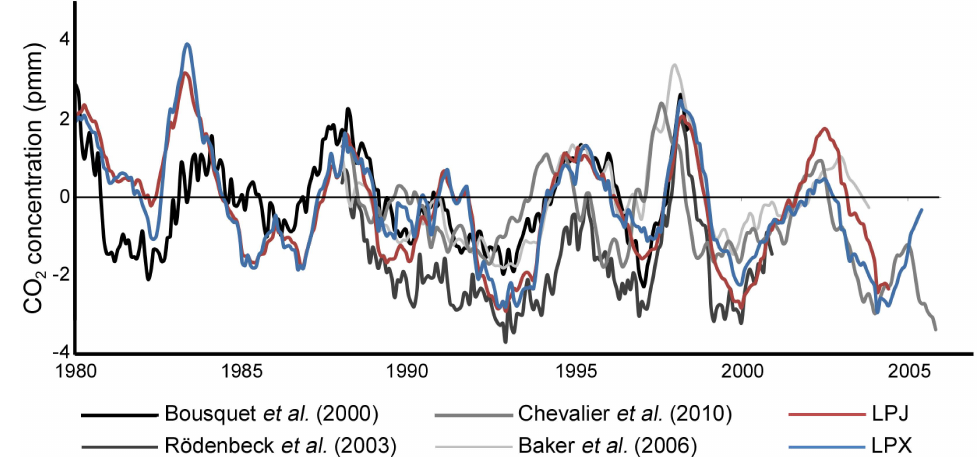
Fig. 10. Twelve-month running mean of inter-annual variability in global atmospheric CO 2 concentration between 1998–2005 from Bousquet et al. (2000), R ¨ odenbeck et al. (2003), Baker et al. (2006) and Chevalier et al. (2010) compared to simulated inter-annual variability from LPJ and